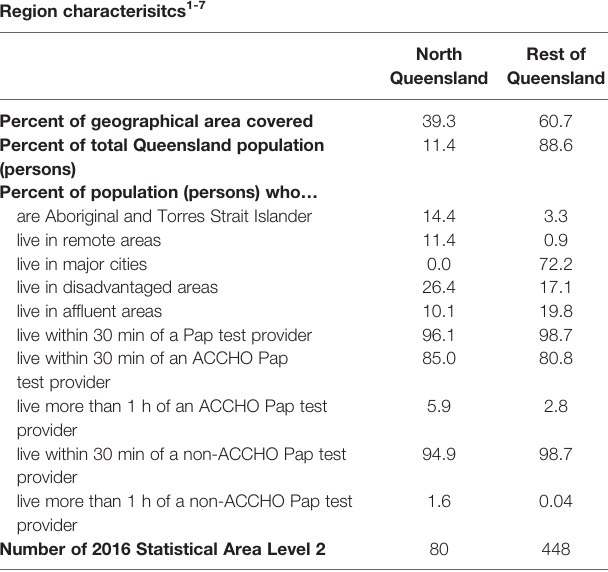
TABLE 1 | Regional characteristics, Queensland, Australia